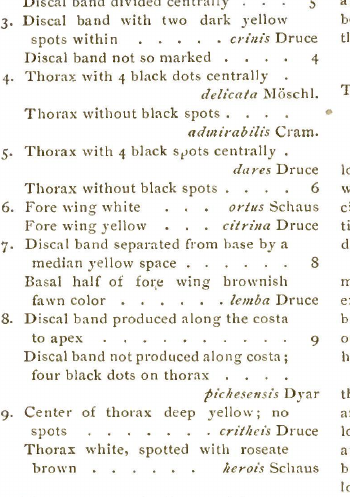
Discal band divided centrally 3· Discal band with two dark yellow spots within . . . . . critzis Druce Discal band not so marked . . . . 4· Thorax with 4 black dots centrally . delicata 1\Toschl. Thorax without black spots . . . . admirabilis Cram. S· Thorax with 4 black Spots centrally . dares Druce Thorax without black spots . . . . 6. Fore wing